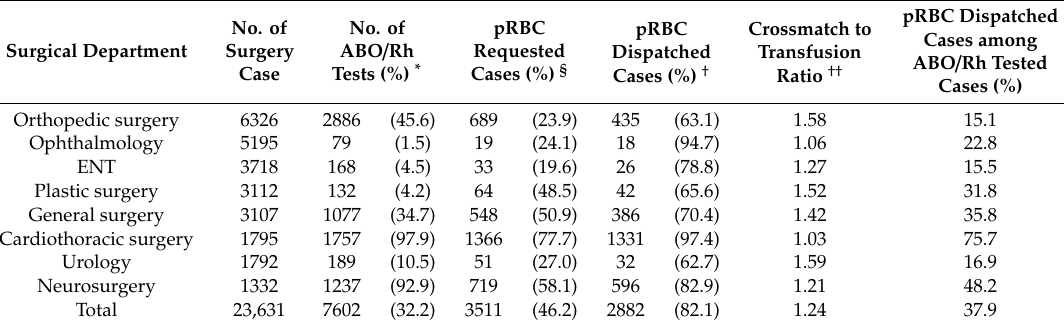
Table 1. Incidence of ABO / Rh type and screening and transfusion.